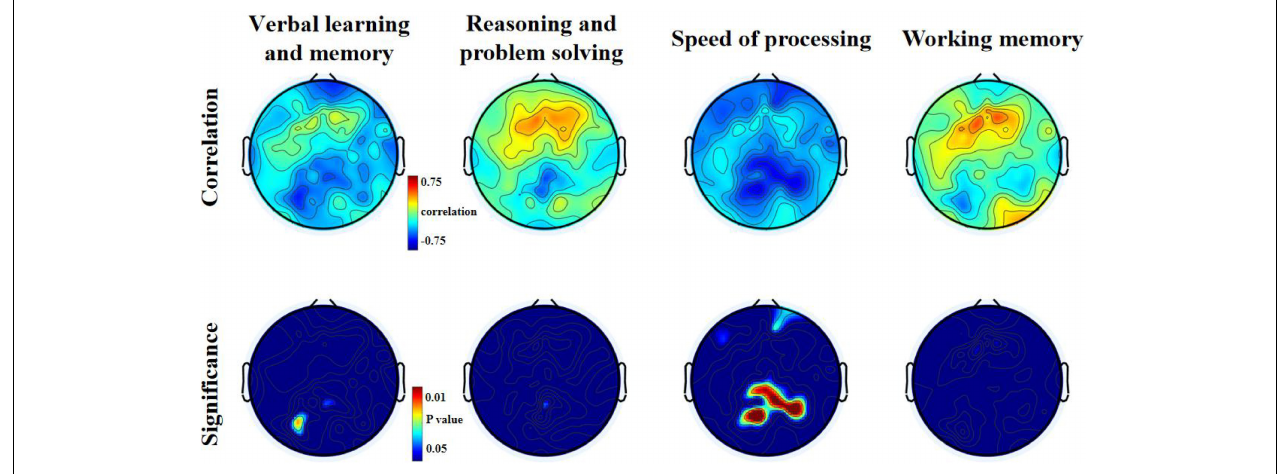
FIGURE 3 | Relationship between theta relative power and MCCB domains T-scores for the eyes open condition in patients with